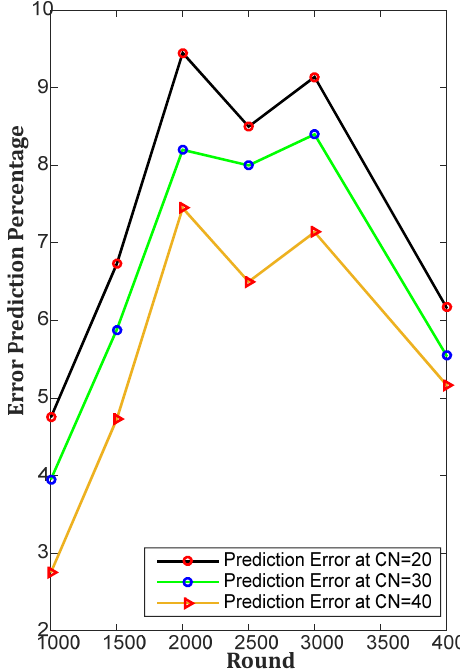
Figure 10. Prediction error vs. round.